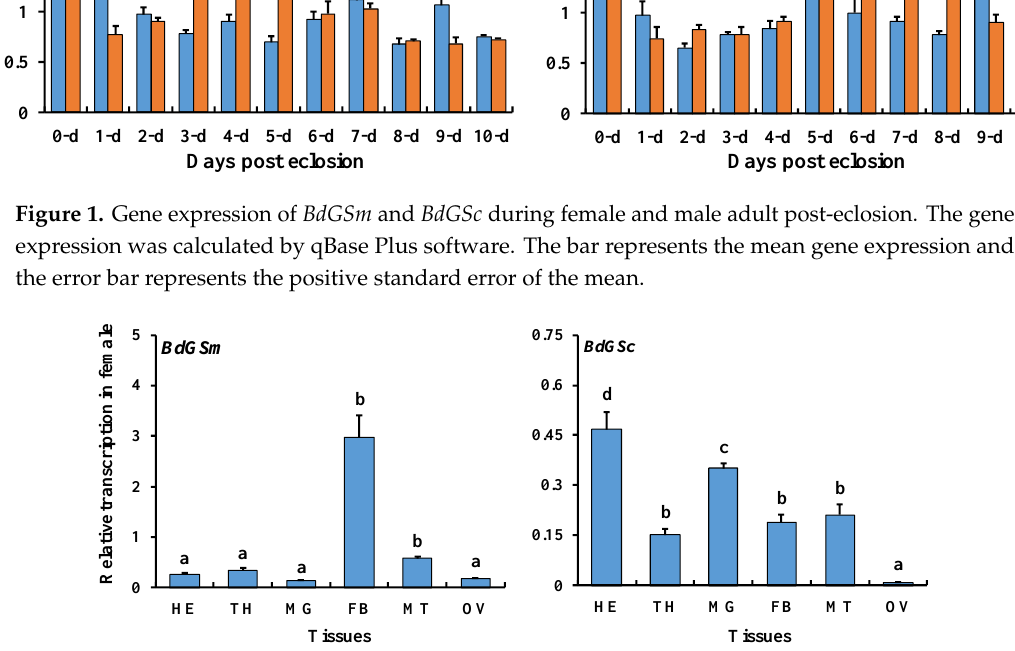
Figure 2. Gene expression of BdGSm and BdGSc among tissues from 9-day-old female adults. HE, TH, MG, FB, MT, and OV stand for head, thorax, midgut, fat body, Malpighian tubules and ovary, respectively. The gene expression was calculated by qBase Plus software. The bar represents the mean gene expression and the error bar represents the positive standard error of the mean. A different letter on the bar indicates a significant difference analyzed by ANOVA with a Tukey LSD test using SPSS 19.0 ( P < 0.05).